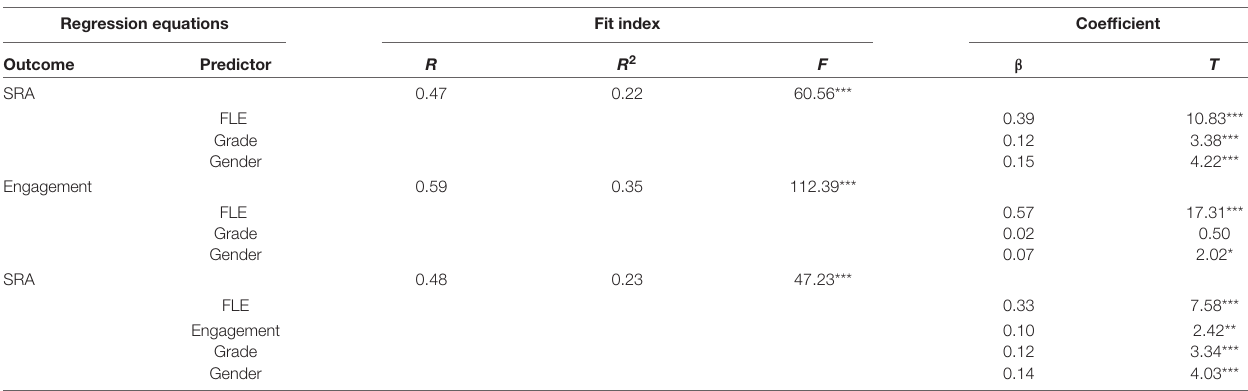
TABLE 3 | Regression results of model 1.